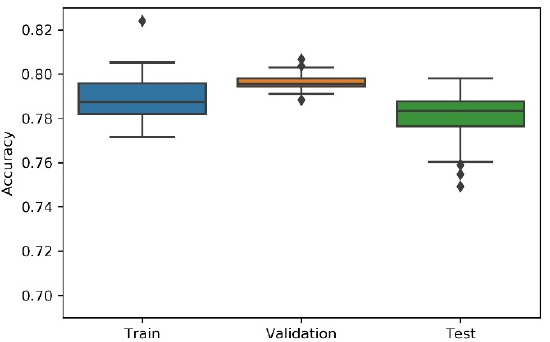
Figure 11. Experiment’s performance for Approach B (Genetic) accuracy (in %).